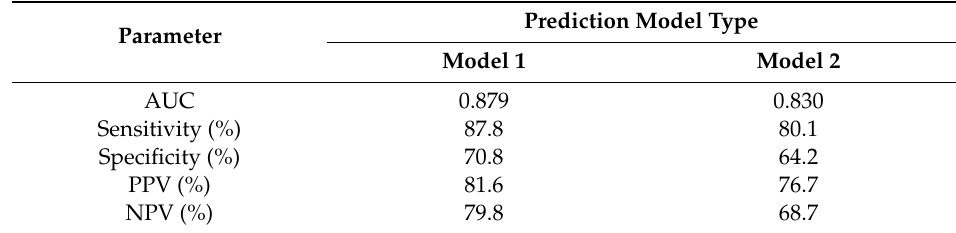
Table 5. Parameters describing the accuracy of MR prediction using two binary logistic prediction